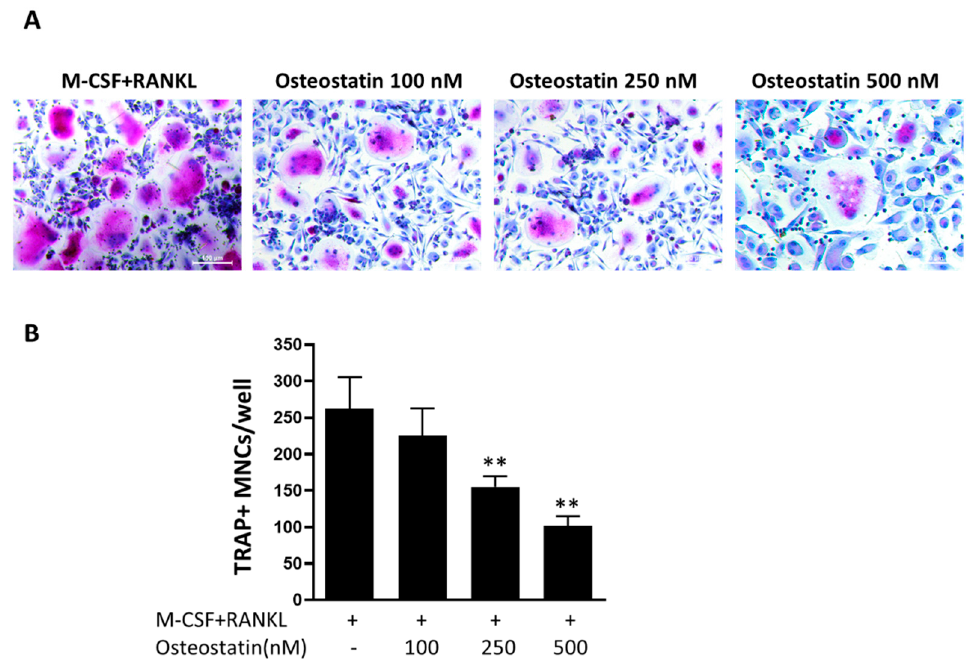
Figure 1. The effects of osteostatin on osteoclast differentiation. Osteoclast precursors were stimulated with M-CSF and RANKL for osteoclast differentiation in the presence or absence of osteostatin (final concentrations: 100, 250 and 500 nM) for 7–9 days. Cells were TRAP and hematoxylin stained, and TRAP + positive cells with 3 or more nuclei were counted under a light microscope. ( A ) Representative images; Bar = 100 μ m. ( B ) TRAP + multinucleated cells (MNCs) per well are expressed as the mean ± S.D. of three independent experiments; ** p < 0.01 vs. M-CSF+RANKL.